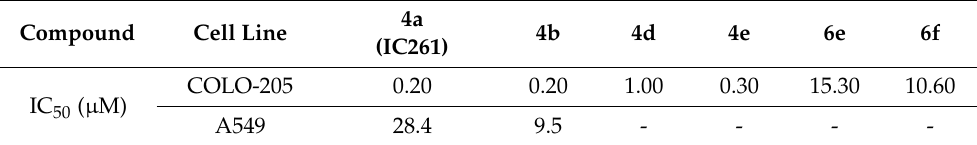
Table 2. IC 50 of compounds 4a ( IC261 ), 4b , 4d , 4e , 6e and 6f against COLO-205 using SRB assay and IC 50 of compounds 4a ( IC261 ), 4b against cell line using MTT assay.